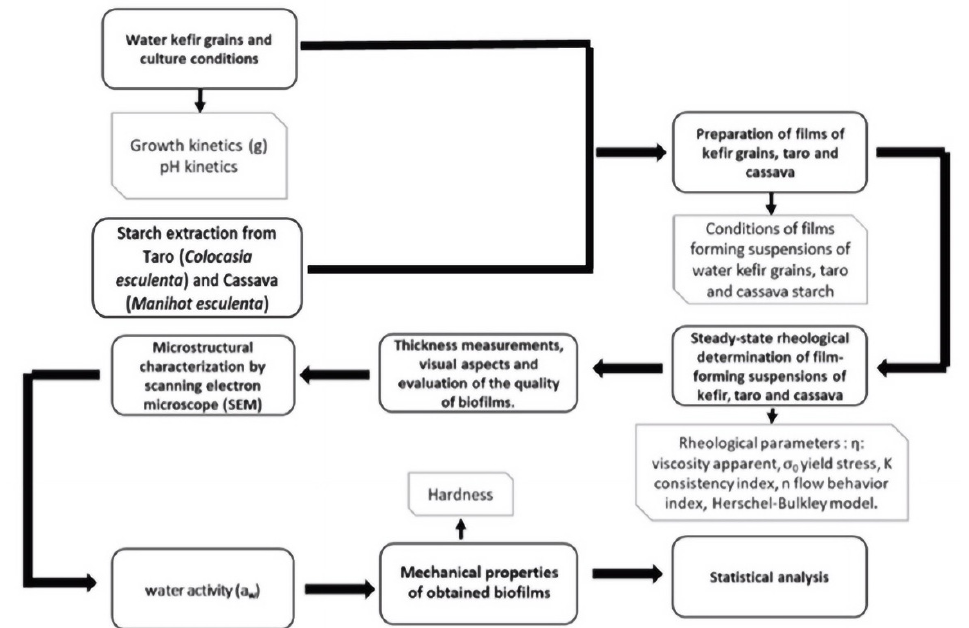
Figure 1. General methodology of the process for obtaining new edible biofilms from water kefir grains in comparison with conventional films from Taro ( Colocasia esculenta ) and Cassava ( Manihot esculenta ) starch.